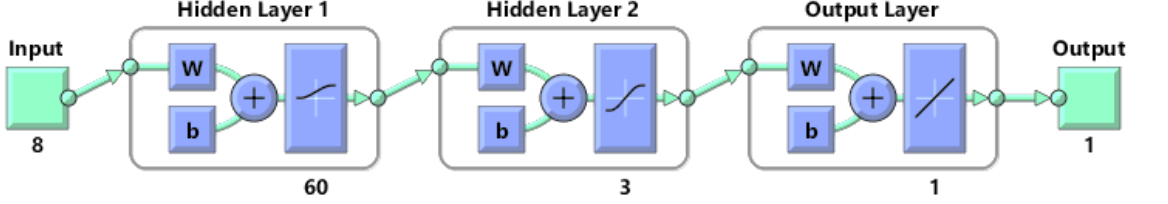
Figure 10. New neural network structure with activation function. Table 5. New artificial neural network features.